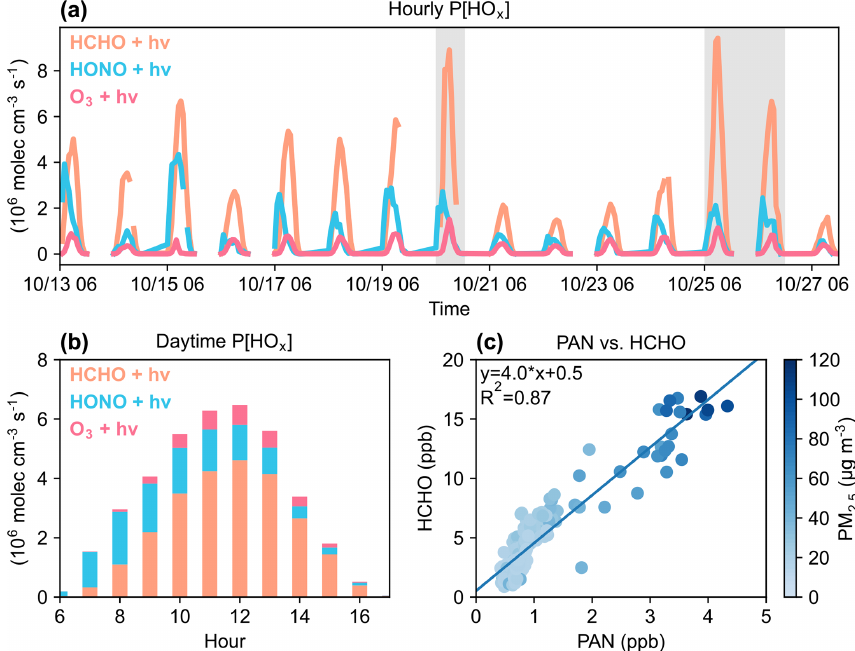
Figure 9. (a) Hourly time series of calculated HO x production rates ( P [HO x ]) through the photolysis of O 3 , HONO, and HCHO during 06:00–17:00LT from 13 to 27 October at the SDZ site. (b) Daytime P [HO x ] through each pathway, averaged over 13–27 October. (c) Day- time PAN concentrations versus HCHO concentrations from 13 to 27 October at the SDZ site. The colors denote the corresponding PM 2 . 5